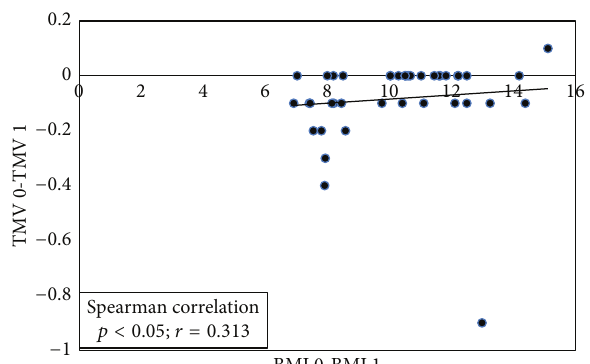
Figure 1: This figure shows that correlation between changes in total macular volume (TMV) and changes in body mass index (BMI). TMV 0: preoperative TMV; TMV 1: 3-month postoperative TMV; BMI 0: preoperative BMI; BMI 1: 3-month postoperative BMI.